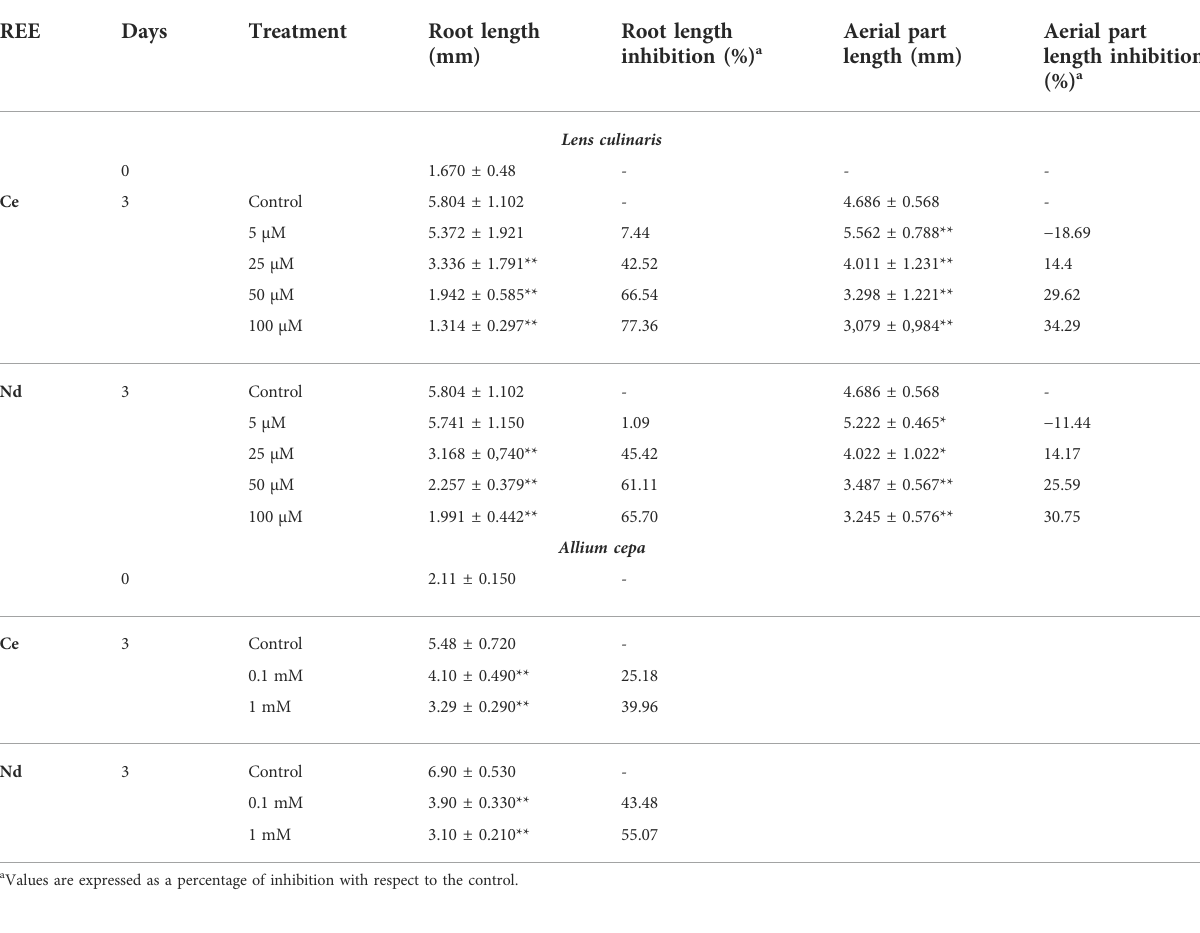
Frontiers in Environmental